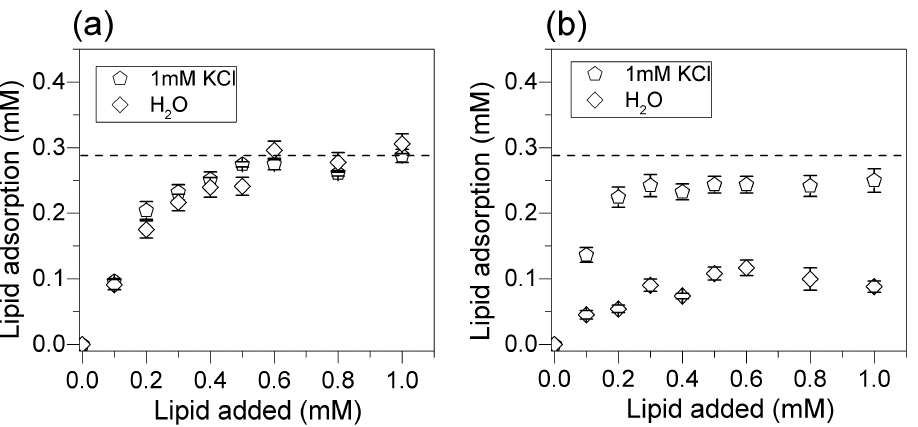
Figure 7. Adsorption isotherms for DODAB from films or BF onto silica. ( a ) Mean DODAB adsorption onto silica (2 mg/mL) from DODAB films. ( b ) Mean DODAB adsorption onto silica (2 mg/mL) from DODAB BF. The dashed line at 0.288 mM DODAB represents the theoretical concentration corresponding to bilayer adsorption. Each mean adsorption value and respective mean standard deviation was obtained from at least two different determinations for each element.